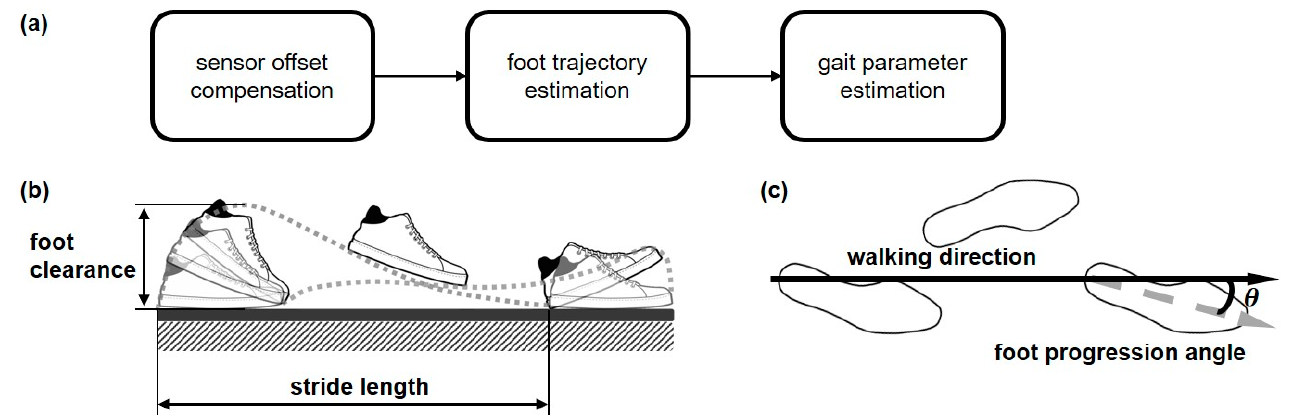
Figure 3. Gait analysis and its parameters: ( a ) Flowchart of the gait parameter estimation algorithm; ( b ) Gait parameters: foot clearance and stride length; ( c ) Gait parameter: foot progression angle.